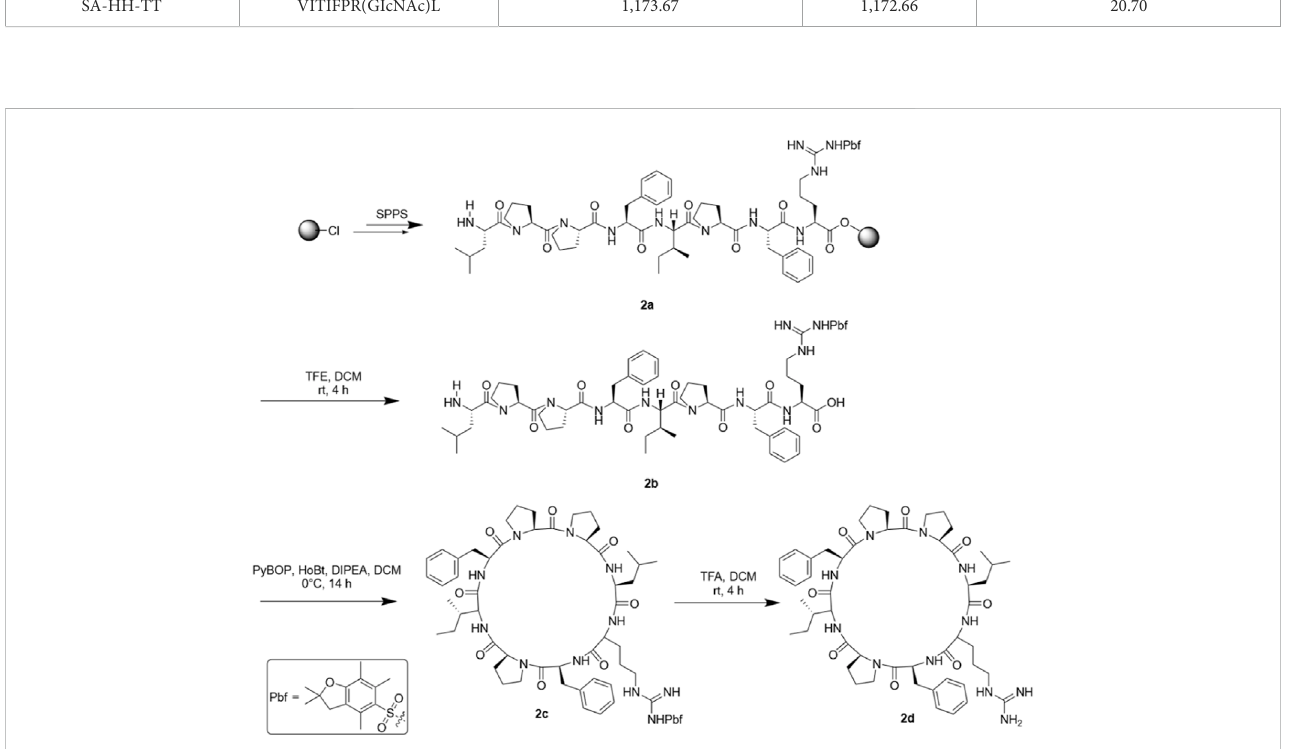
FIGURE 4 Synthesis route of